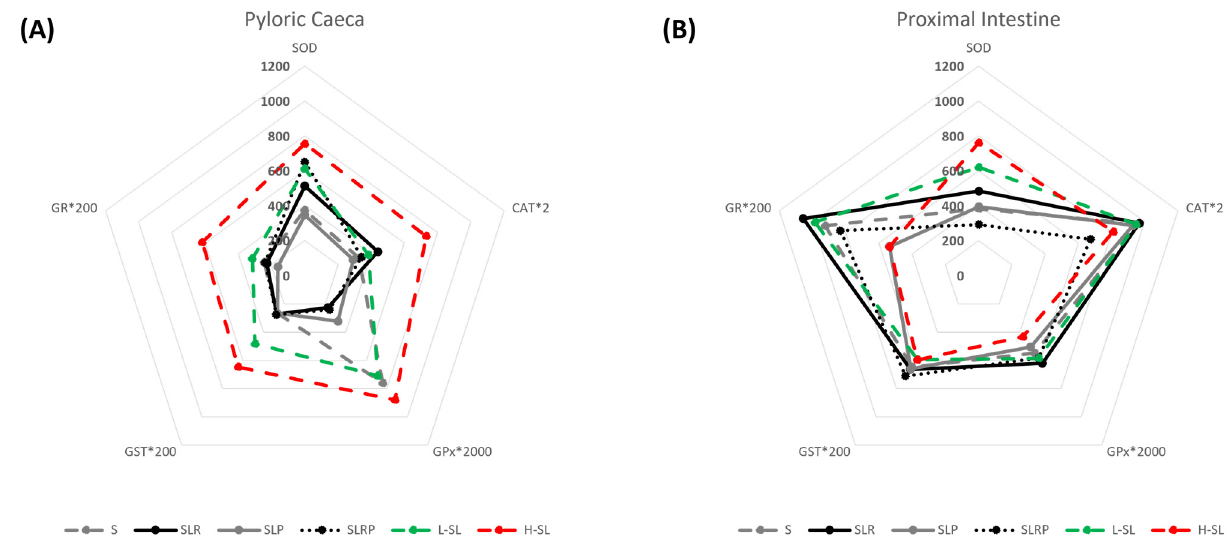
Figure 1. Antioxidant activities in pyloric caeca ( A ) and proximal intestine ( B ) at 24 h post feeding sea bream fed experimental diets. Enzyme activities are expressed as U *mg prot − 1 and CAT, GPx, GST and GR were scaled to place them in the same chart and visualise better the differences between experimental conditions. Values are the mean (n = 3 in H-SL, n = 6 in S and L-SL, n = 9 in SLR, SLP and SLRP). Table 5. Antioxidant enzymes activities (U x mg prot − 1 ) in pyloric caeca and proximal intestine 24 h post-feeding in sea bream fed the experimental diets.